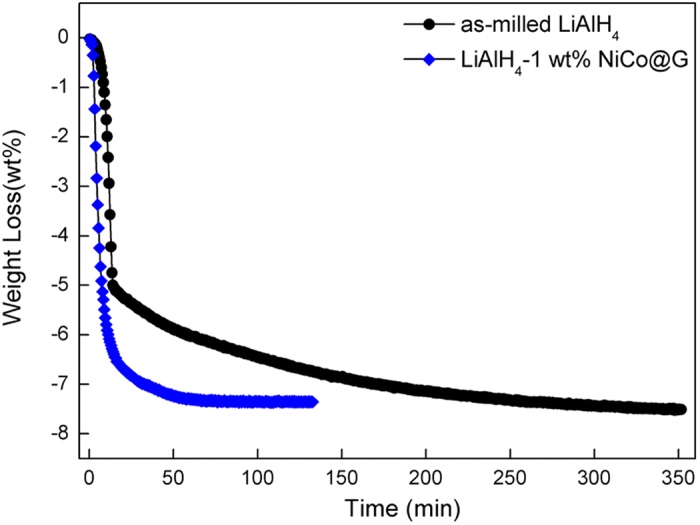
Isothermal dehydrogenation curves of as-milled LiAlH4 and LiAlH4-1 wt% NiCo@G at 150 °C.